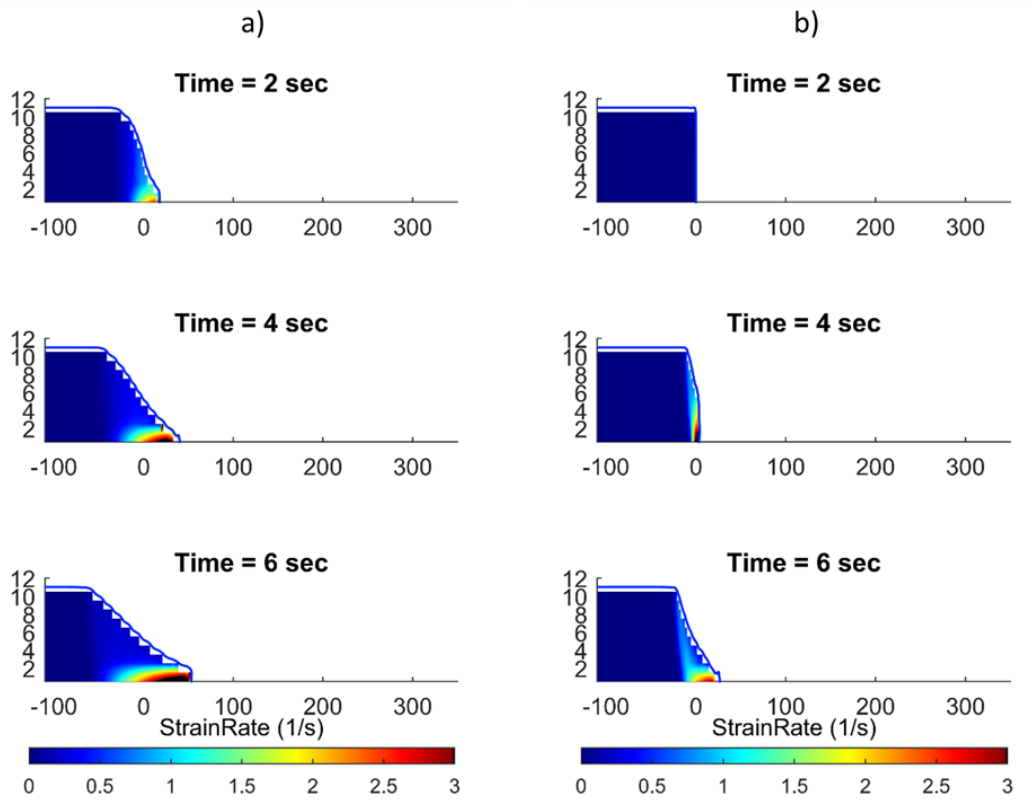
Figure 12. Snapshots of strain rate profile at the early stage on the centerline cross-section of the breach (y = 220 m). ( a ) Bingham model (BM); ( b ) modified bi-viscosity model (MBM).